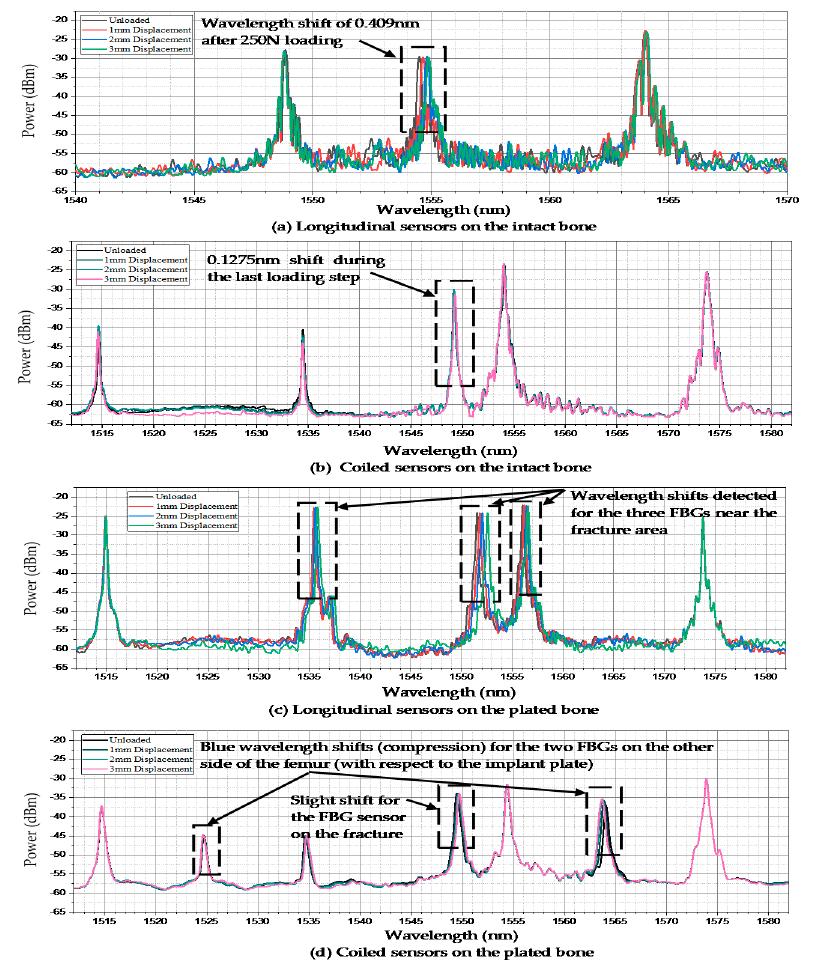
Figure 4. Wavelength shifts of the FBG arrays anchored on the femur sawbones. ( a ) Longitudinal sensors on the intact bone; ( b ) Coiled sensors on the intact bone; ( c ) Longitudinal sensors on the plated bone; ( d ) Coiled sensors on the plated bone.